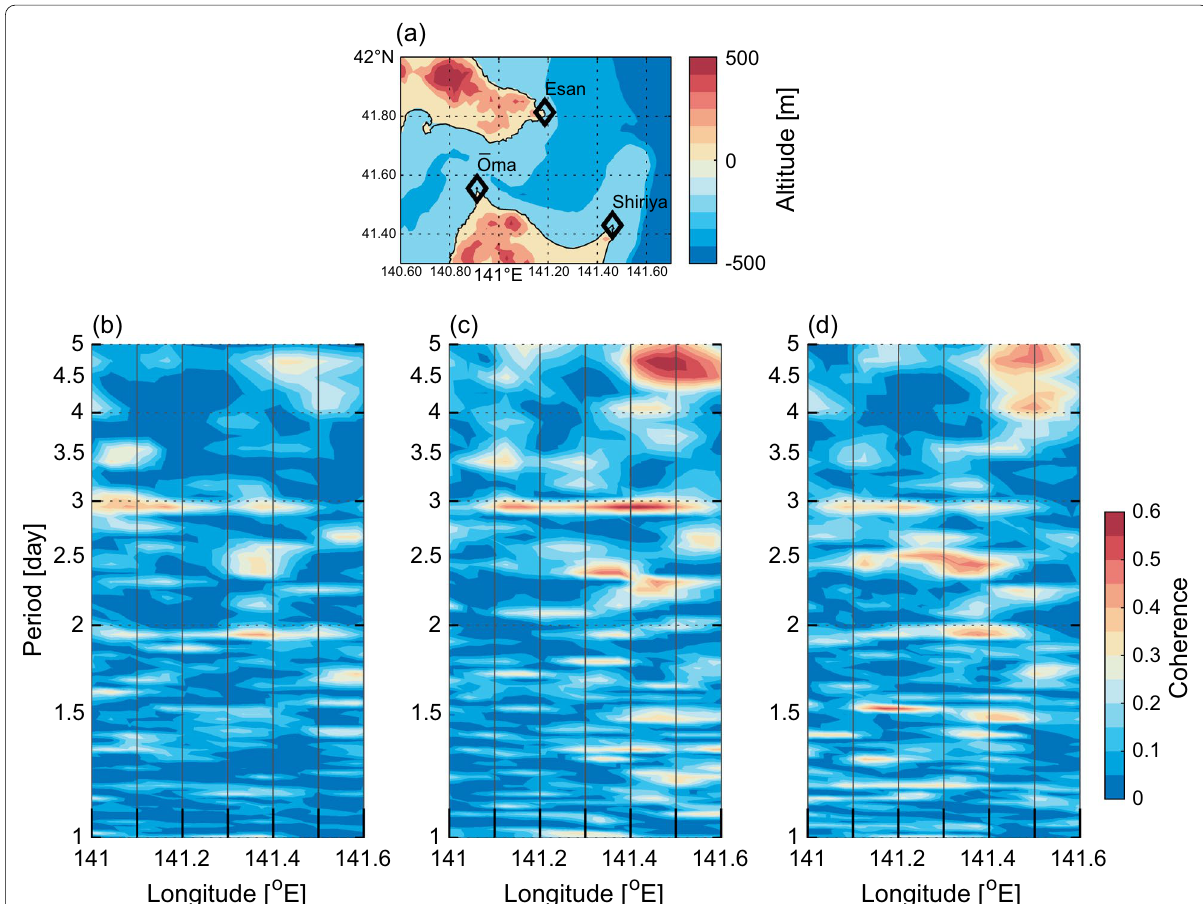
Fig. 14 a Location of wind observation points. b , c , and d : Coherence of the axis latitude variation in each subregion with zonal wind at Shiriya, Esan, and Ōma, respectively, for